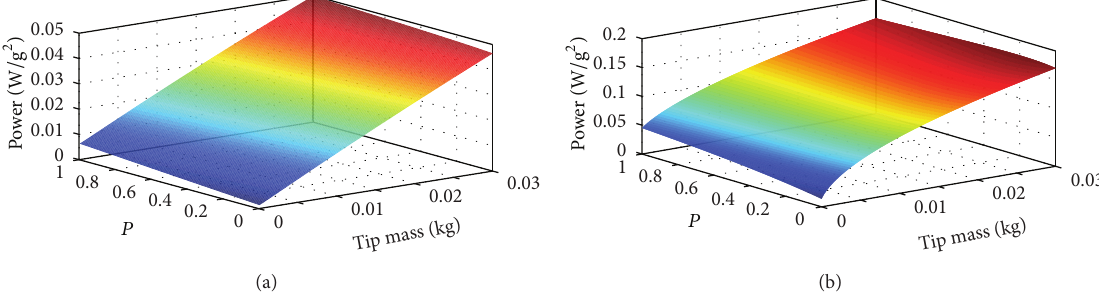
Figure 7: Variation of power output (per squared based acceleration) with parameter 𝑃 and tip mass.